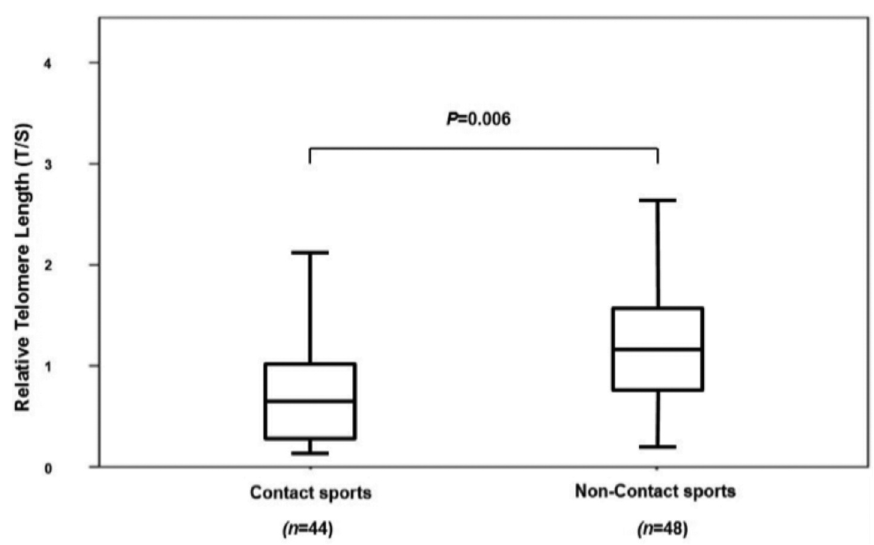
Box-plot illustrating relative telomere length distribution in ACL rupture subjects between contact sports and non-contact sport. Fig. 2: The line through the middle of the boxes represents the median of T/S value and the top and bottom of each box represents the first and third